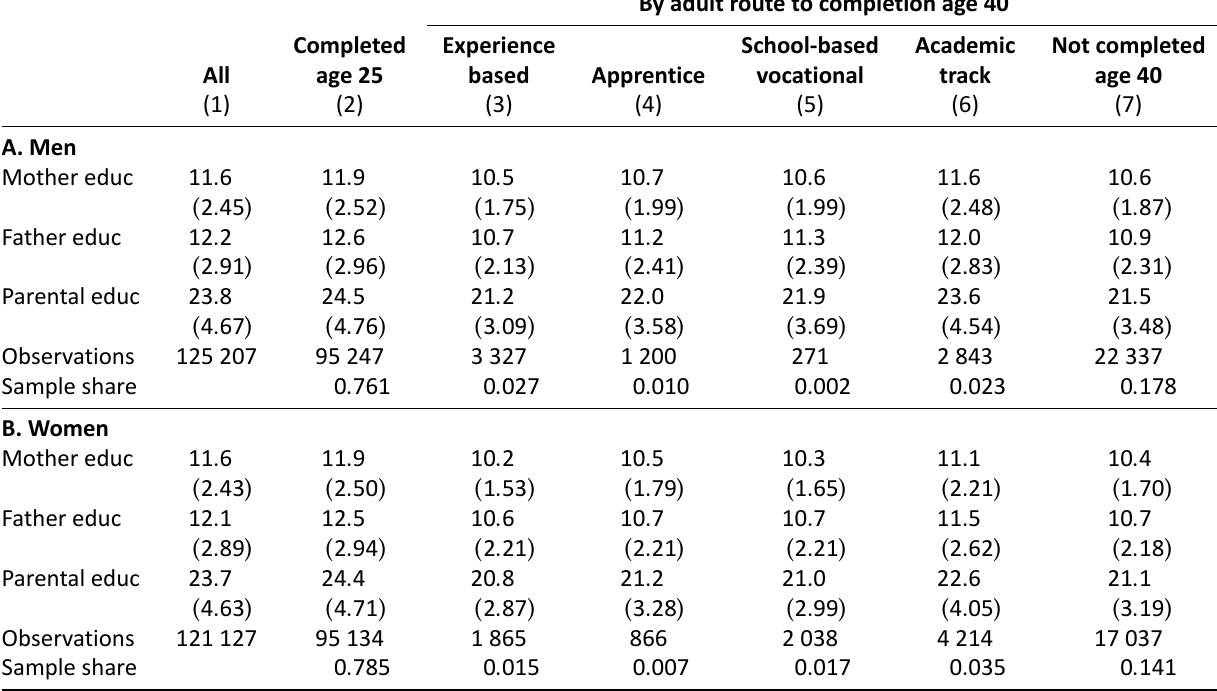
Table 1. Descriptive statistics: parental education.